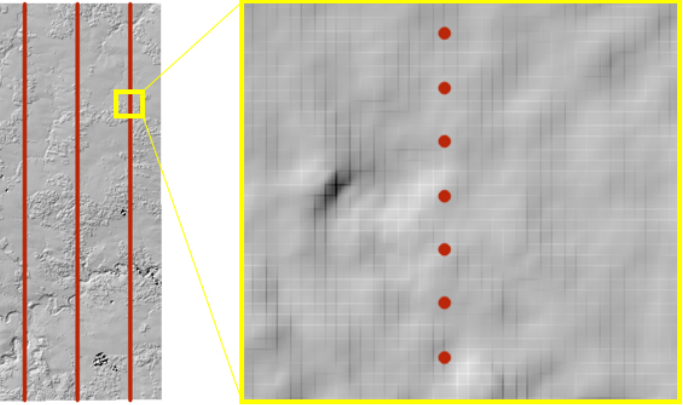
Figure 5. Definition of 3D point profile-lines at 10 m intervals.